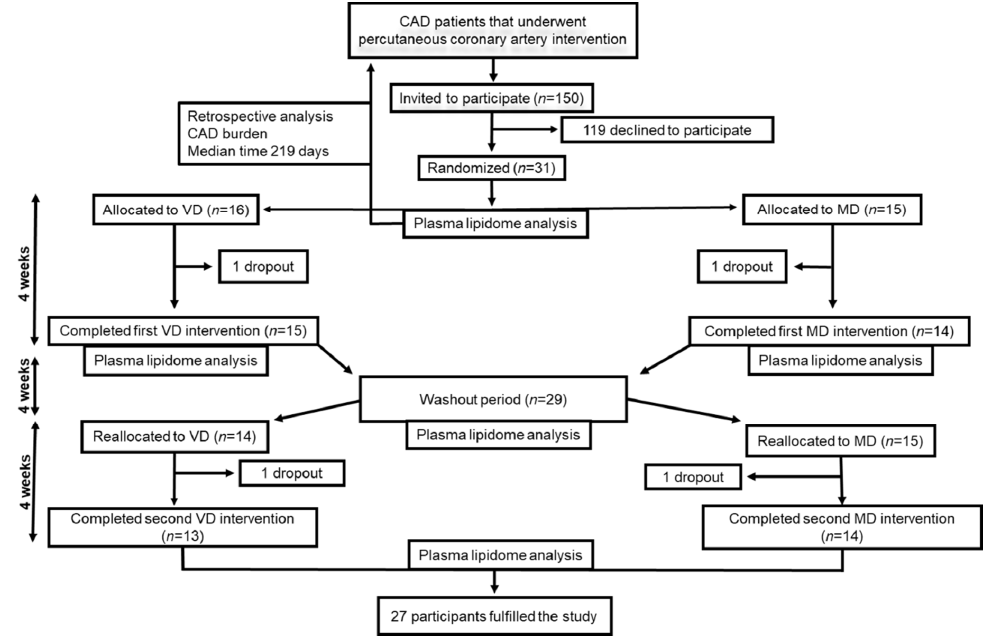
Figure 1. The workflow of study. CAD, coronary artery disease; MD, meat diet; VD, vegetarian diet.